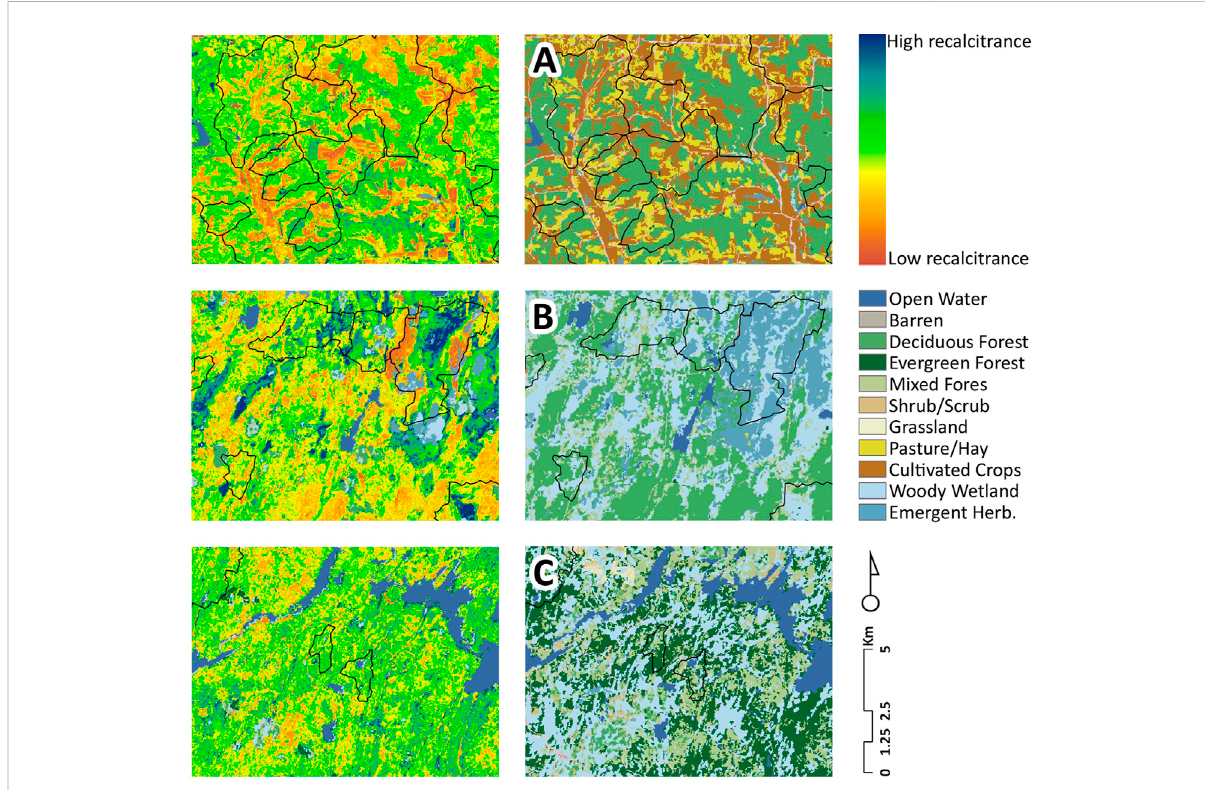
FIGURE 5 Maps of latent variable RETENF (nutrient retention due to foliar recalcitrance) derived by applying path weights (Estimate column, Table 5) to AVIRIS-derivedmapsofC:Nratioandlignin:Nratio. Brightercolorsindicateprojected lowlitterrecalcitranceduetohighlitterquality.Panelsonthe right are land cover maps derived from NLCD 2006. Letters refer to location of sites in Figure 1. Polygons indicate watersheds used in the